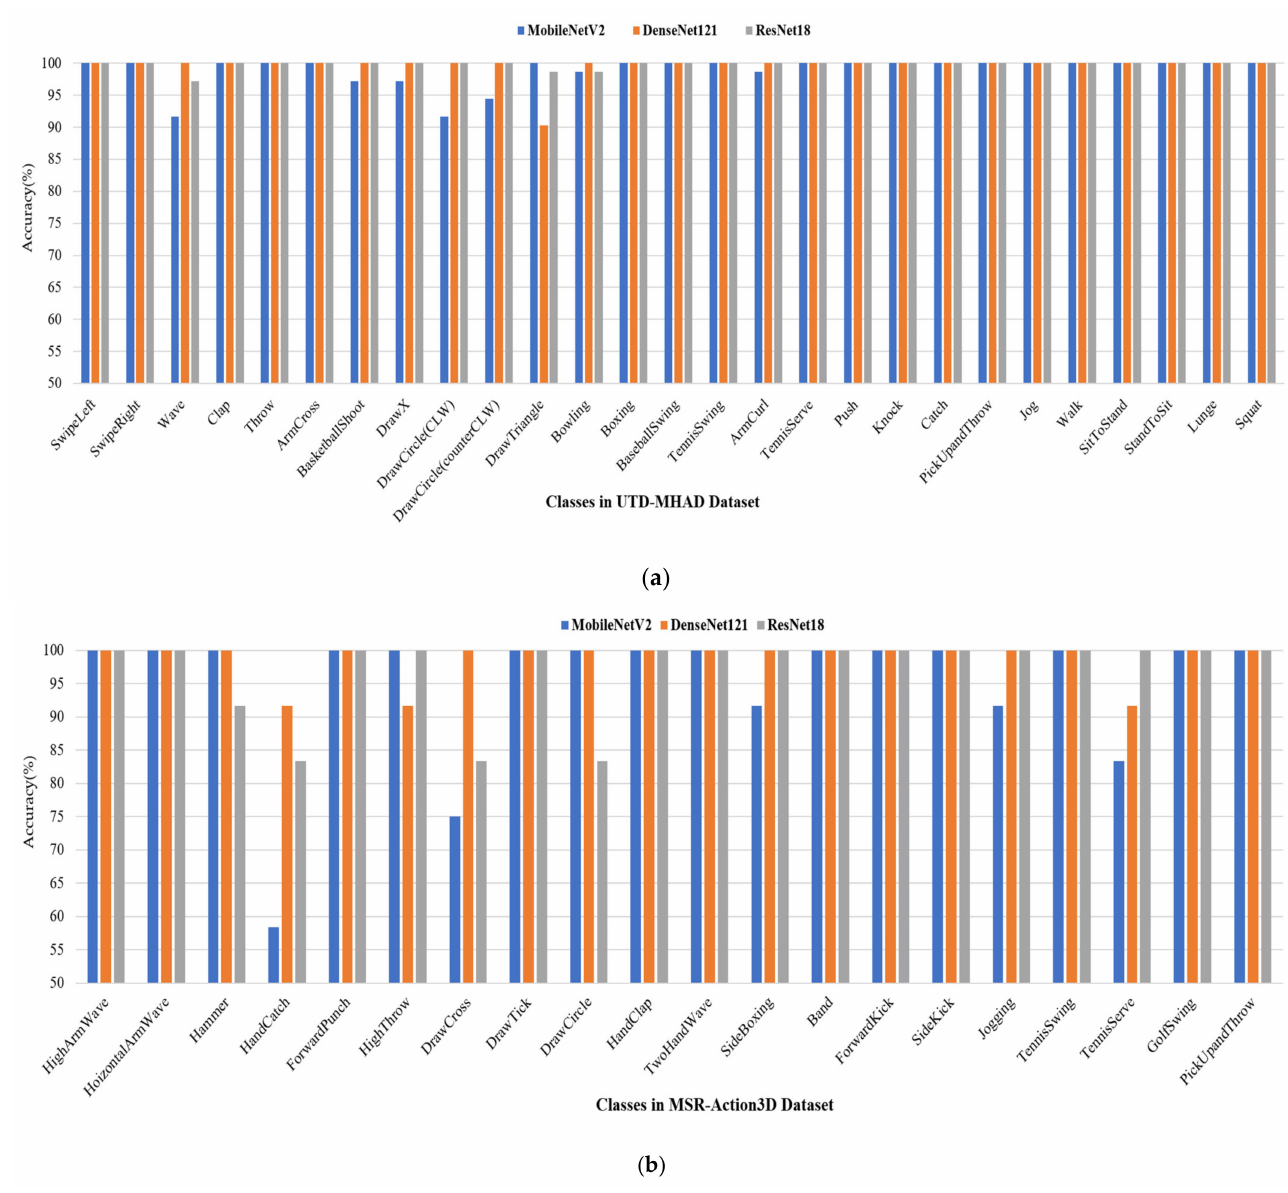
Figure 11. Classification performance of the proposed system based on individual classes in ( a ) UTD-MHAD and ( b ) MSR- Action3D datasets. Table 5. Performance comparisons of human action recognition using UTD-MHAD